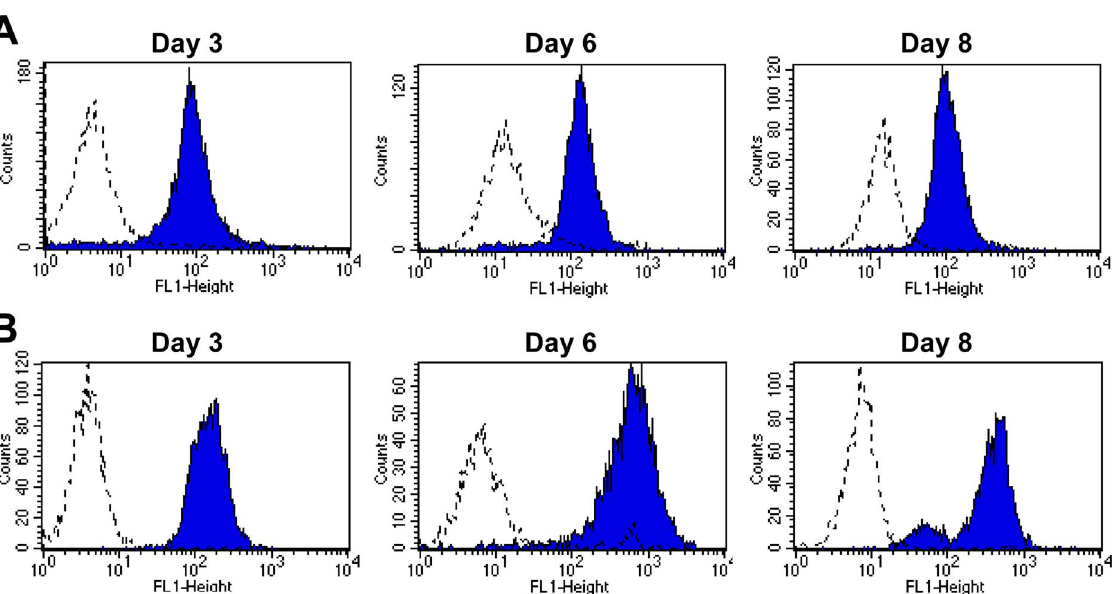
Figure 4. Human monocyte-derived macrophages and dendritic cells express integrin a D b 2 during differentiation in culture. Unfractionated monocytes were separated from the venous blood of healthy subjects by positive selection and differentiated to (A) macrophages or (B) monocyte-derived dendritic cells using procedures and protocols outlined in Materials and Methods. MDM and MDDC were examined for expression of a D b 2 by flow cytometry on days 3, 6, and 8 in culture. These results are representative of findings in three experiments using cells from different subjects.